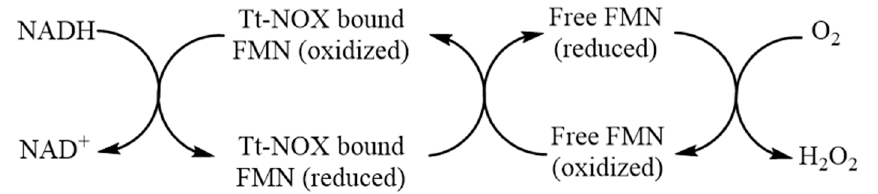
Figure 5. Oxidation of NADH by O 2 in the presence of Tt-NOX and exogenous free FMN. Steady-state kinetic parameters for Tt27-NOX variants were determined (Table 2). The specific activities in FMN saturating conditions of K166/H174/Y194, K166/H174/H194, R166/H174/H194, R166/H174/Y194, and R166/R174/H194 were 68 ± 3.3, 76 ± 6, 50 ± 2.5, 44.3 ± 2.2, and 42 ± 2.1 U/mg,